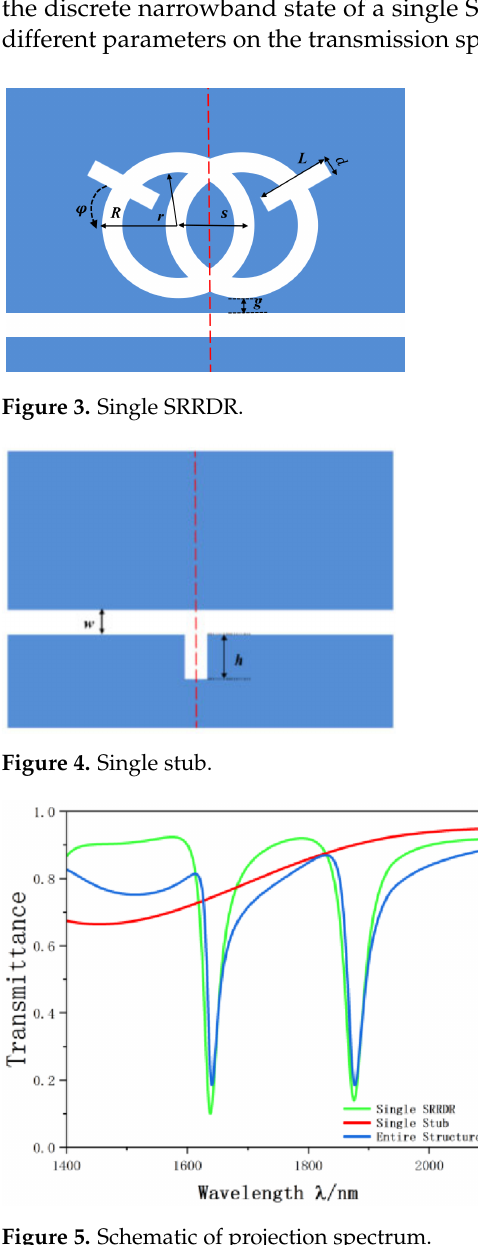
Figure 5. Schematic of projection